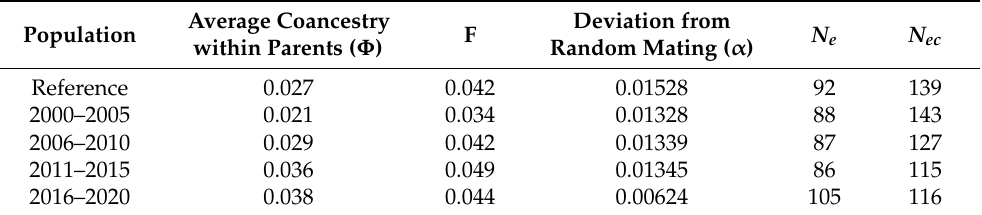
Table 5. Average coancestry within the parental population ( Φ ), average individual inbreeding coefficient according to Meuwissen and Luo (F), degree of deviation ( α ) of random mating from Hardy–Weinberg proportions, realized effective population size ( N e ) and expected effective popula- tion size under random mating ( N ec ) for the reference population and by birth year cohorts. Average Coancestry Deviation from N e N ec Population F within Parents ( Φ ) Random Mating ( α ) Reference 0.027